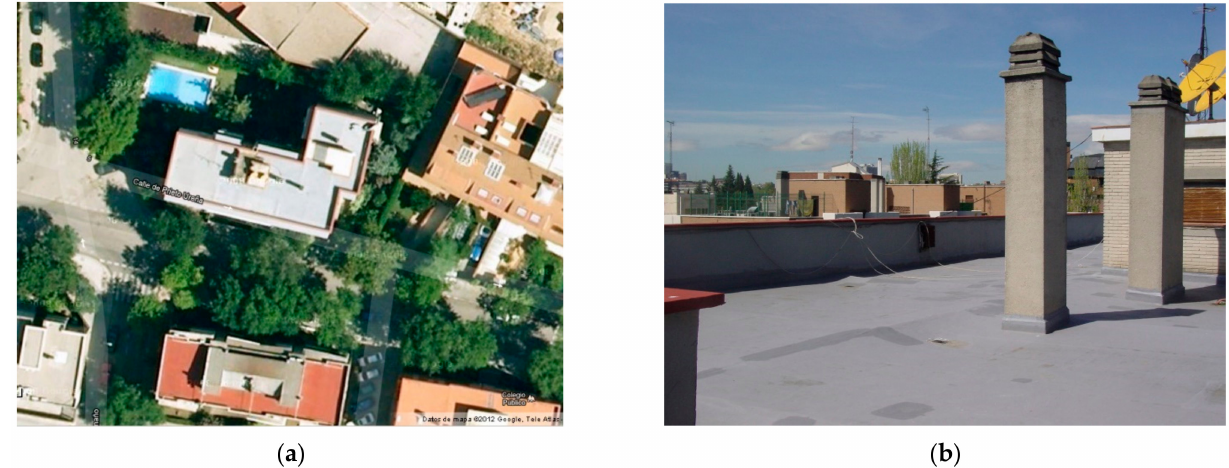
Figure 1. ( a ) Aerial photograph of the building in Madrid; ( b ) detail of the building roof.